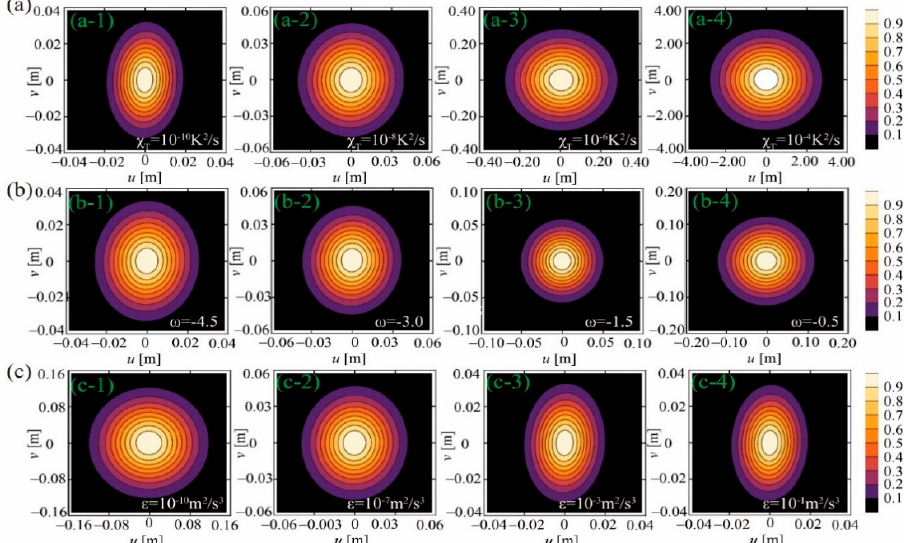
Figure3. Normalizedspectraldensity(contourgraph)ofaTAGSMbeam( µ = 0.005m − 1 )atpropagation Figure 3. Normalized spectral density (contour graph) of a TAGSM beam ( 1 0.005 m μ − = ) at distances z = 0.3 km in oceanic turbulence with di ff erent turbulence parameters: ( a ) χ T ; ( b ) ω ; ( c ) ε . propagation distances 0.3 km z = in oceanic turbulence with different turbulence parameters: ( a ) χ ; ( b ) ω ; ( c ) ε . T